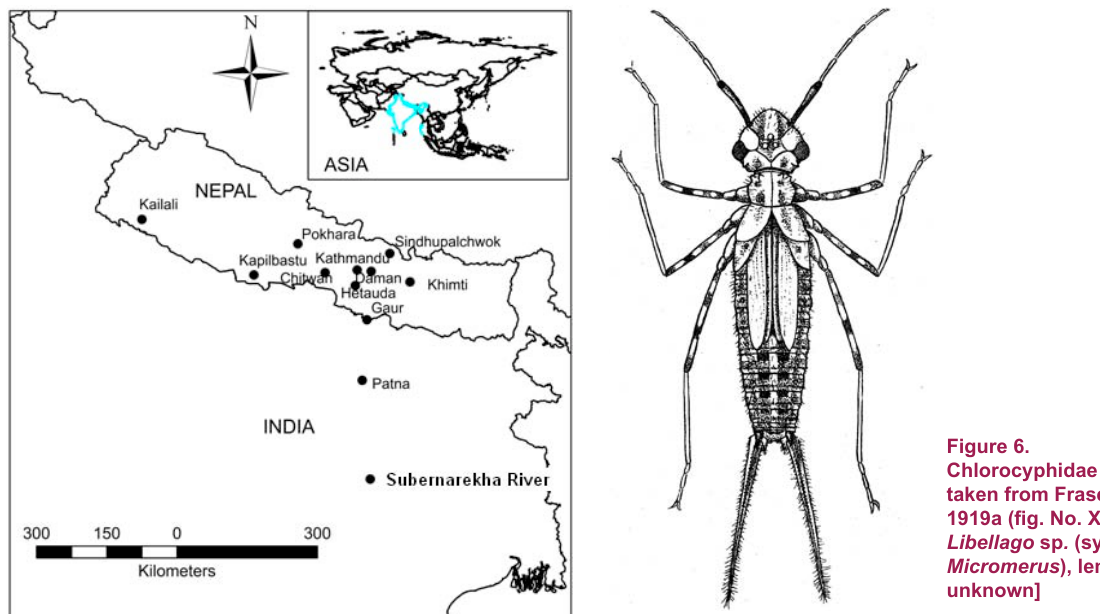
Figure 5. Major study sites in Nepal and